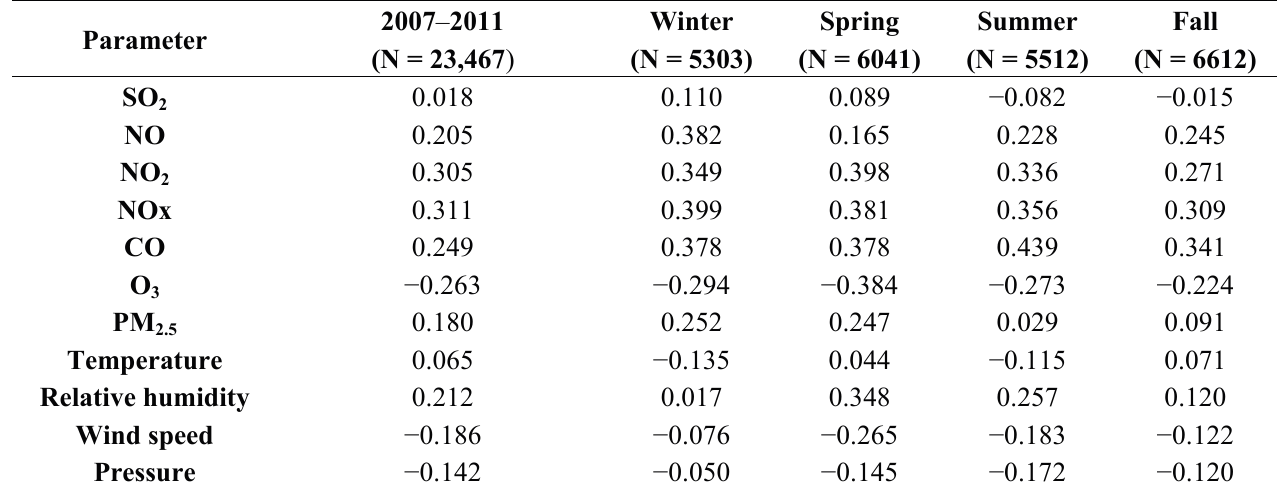
Table 2. Spearman rank correlation coefficients of hourly TGM concentration with other parameters (all significant at p < 0.05 except shaded